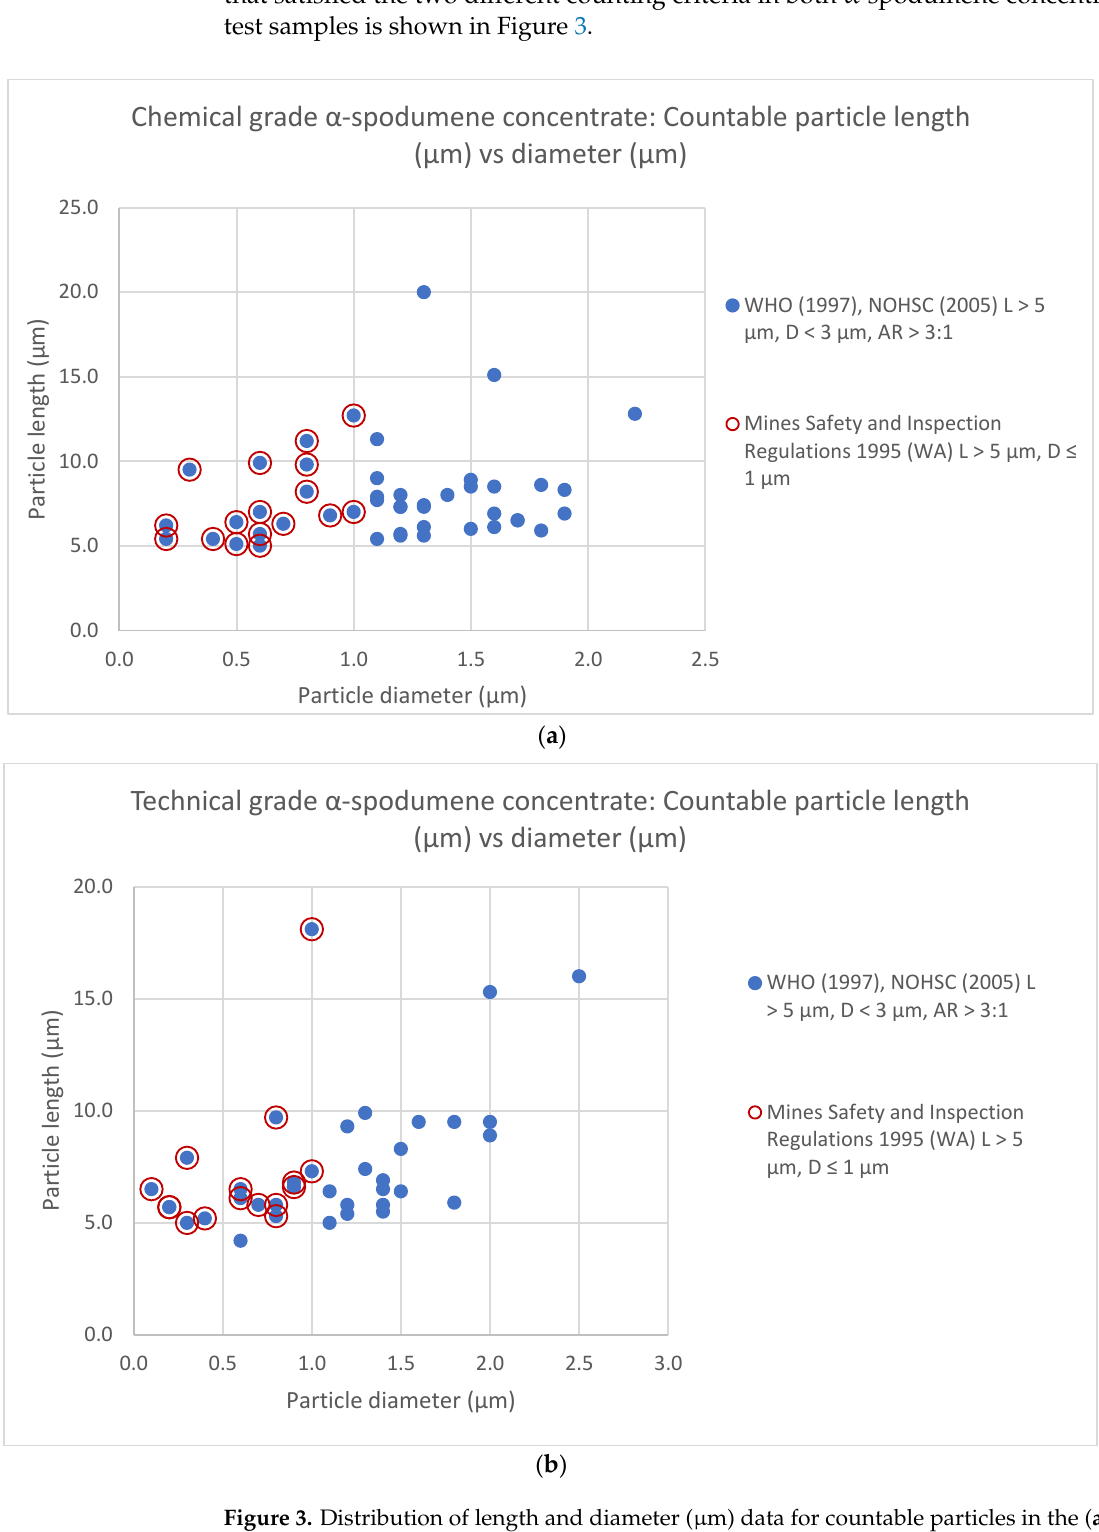
Figure 3. Distribution of length and diameter (µm) data for countable particles in the ( a ) chemical grade α -spodumene concentrate test sample and ( b ) technical grade α -spodumene concentrate test sample.